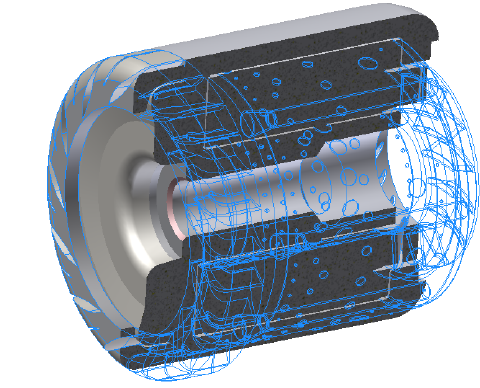
Figure 4: Fluid domain of the GTM-140.